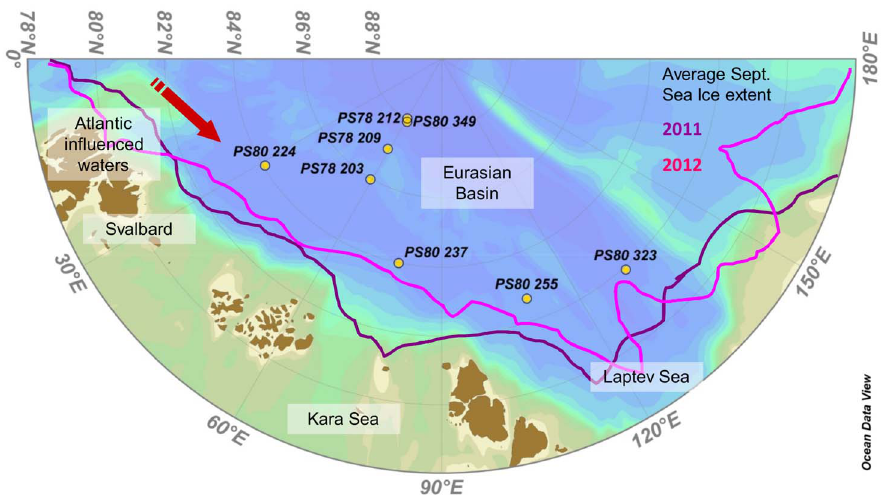
Figure 1. Map of the Arctic Eurasian Basin with sampling stations. Yellow dots represent ice stations where algal aggregates were observed (Expedition PS78/3 took place in summer 2011 and PS80/3 in summer 2012). The purple line corresponds to the September monthly average sea ice extent in 2011 and the pink line in 2012 (Source: http://nsidc.org/data/seaice_index/).